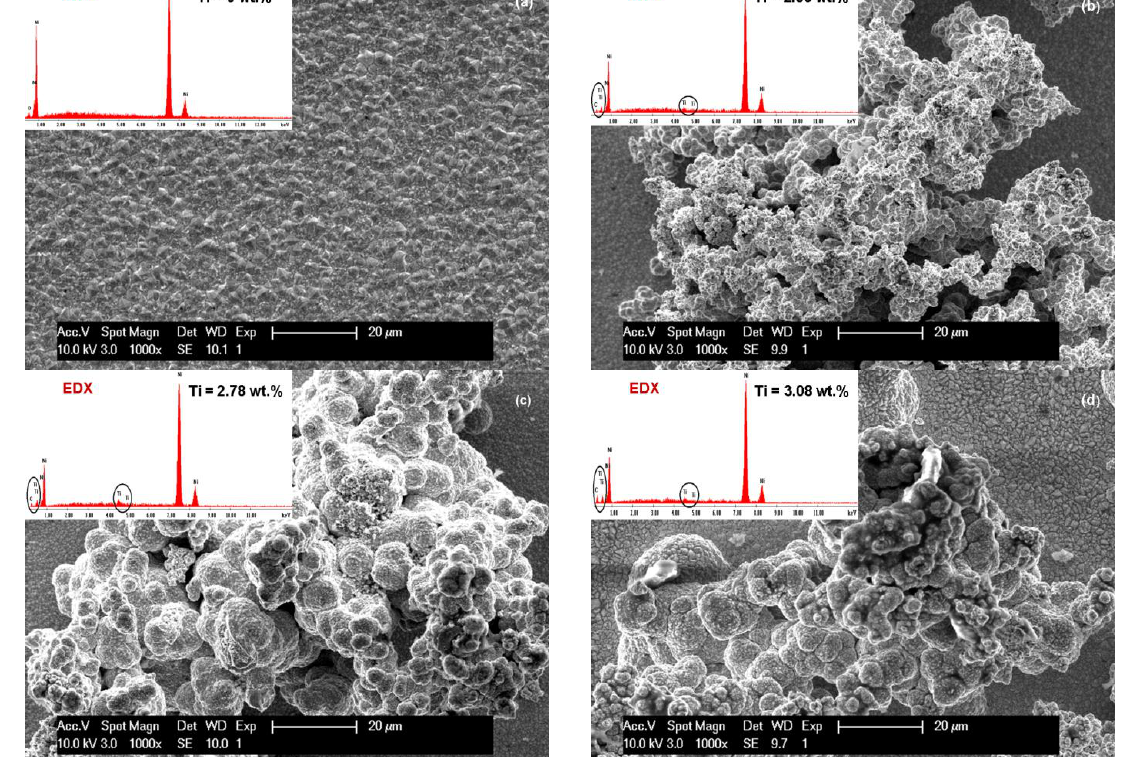
Figure 4. SEM surface morphology and EDX compozition for electrodeposited layers: ( a ) Ni/nano-TiC (0 g · L −1 ); ( b ) Ni/nano-TiC (10 g · L −1 ); ( c ) Ni/nano-TiC (15 g · L −1 ); and ( d ) Ni/nano-TiC (20 g · L −1 ) obtained at current density of 40 mA/cm 2 and deposition time of 30 min. The labelled element in EDX spectrum is titanium (Ti), which confirm the inclusion of TiC particles.